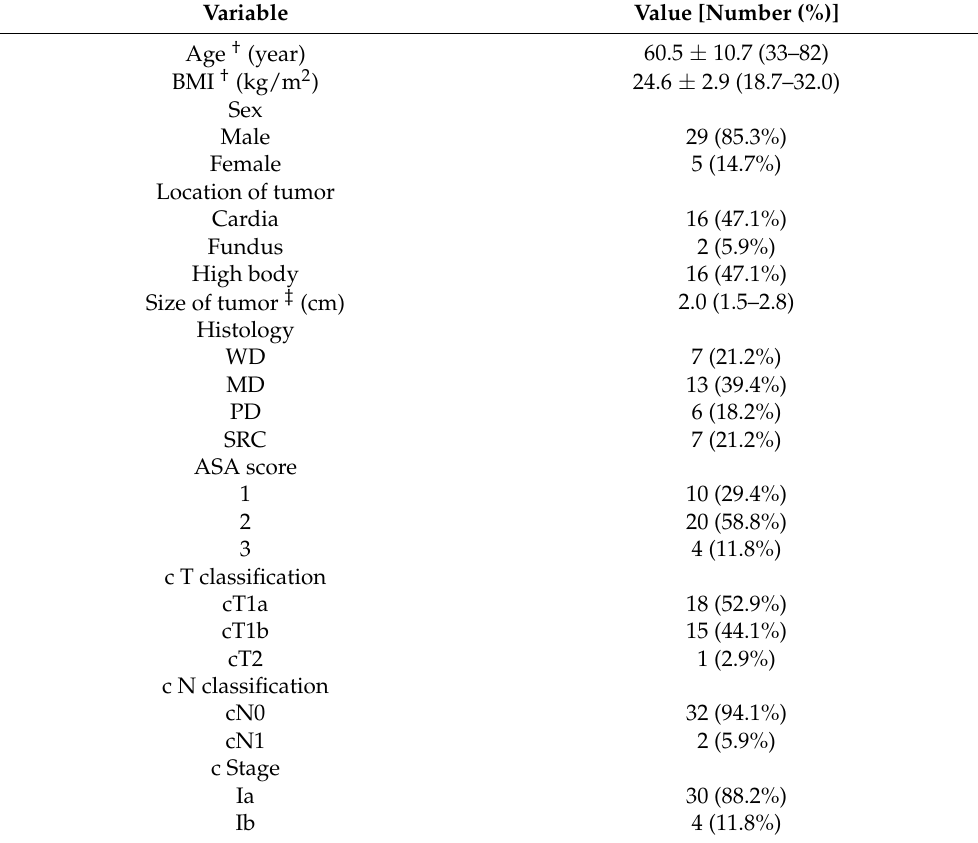
Table 1. Demographic and clinicopathological characteristics of